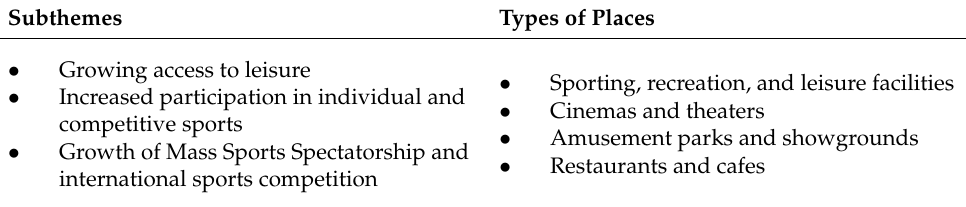
Table 5. Popular Culture and Tourism.